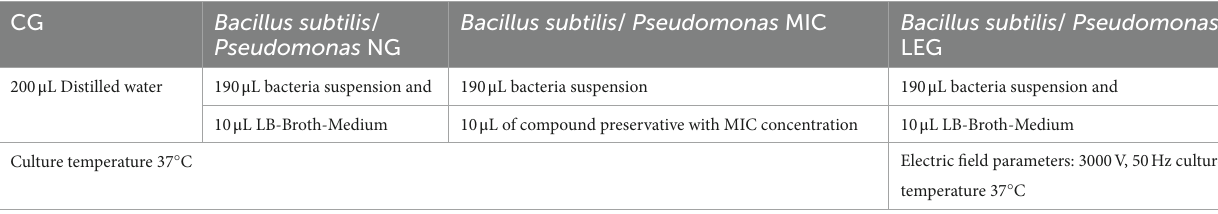
TABLE 1 Grouping of Bacillus subtilis and Pseudomonas growth